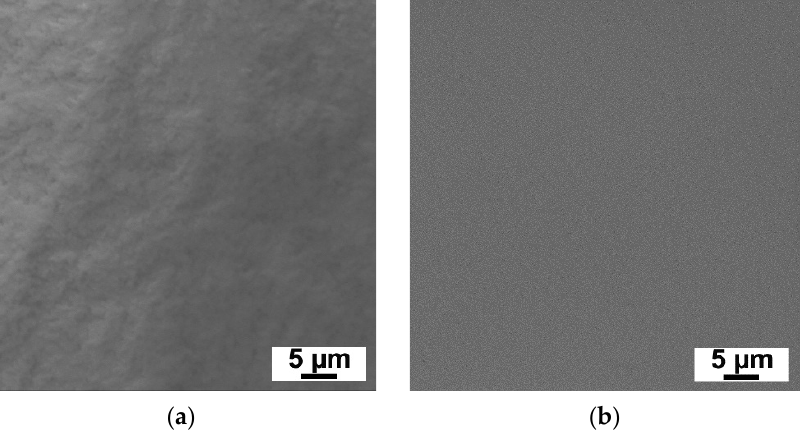
Figure 2. SEM microphotographs of selective layer surface of TFC membranes, content of Al 2 O 3 ·SiO 2 nanoparticles, wt.%: ( a )—0, ( b )—25 wt.%.